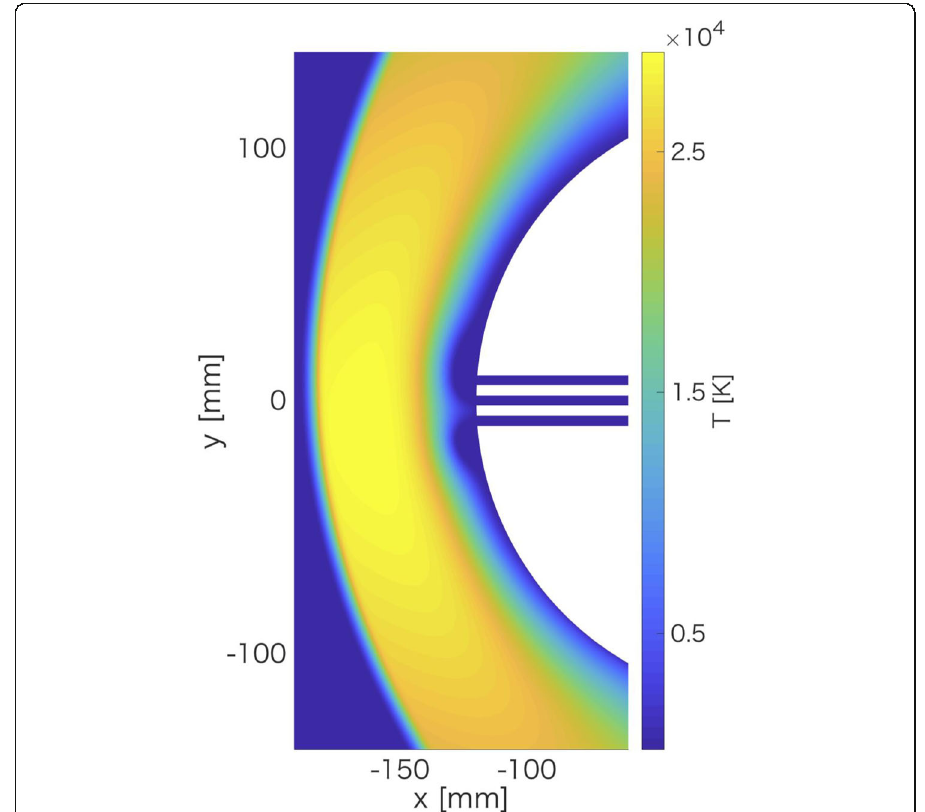
Fig. 11 A snapshot of the temperature field (Case-B, Model-2, Ω = 5°, 1.4 × 10 5